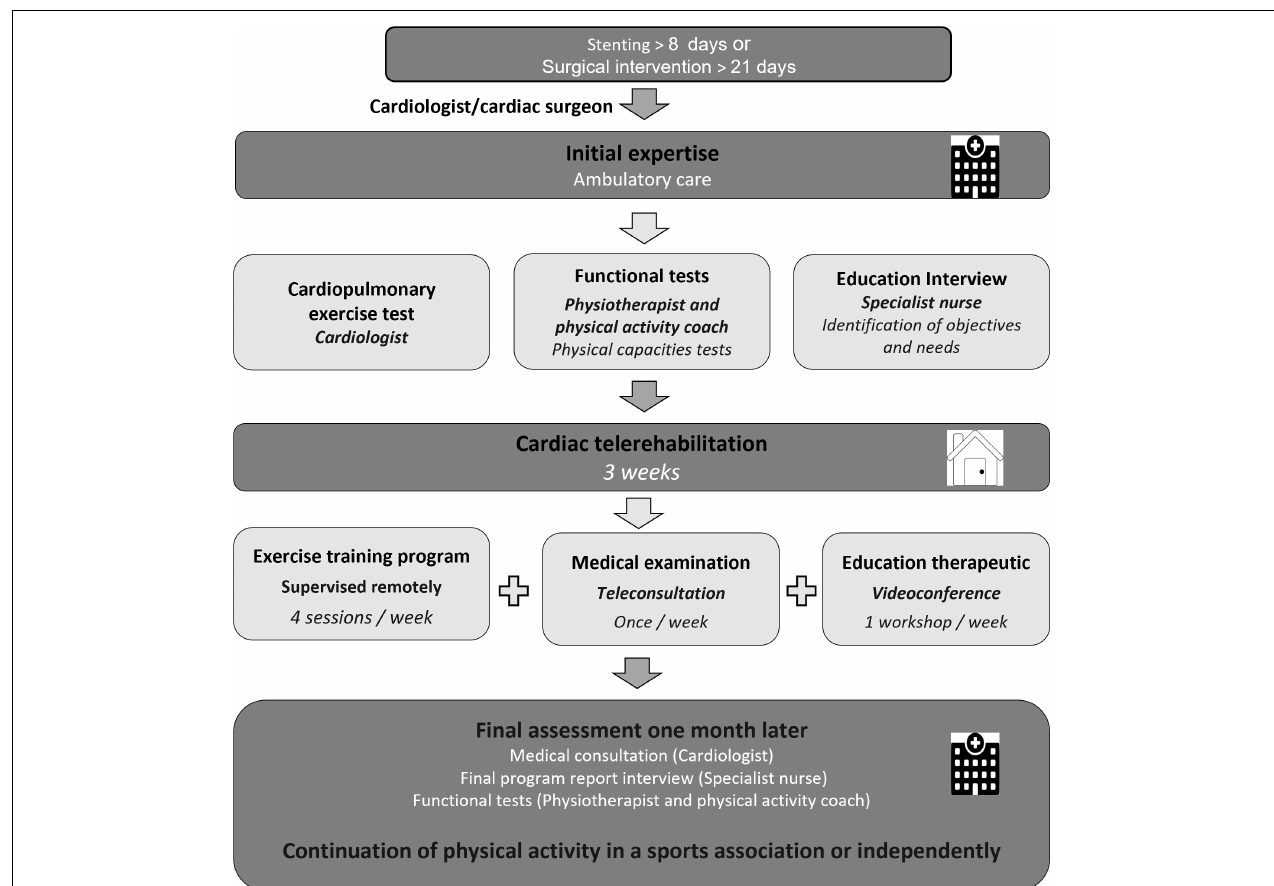
FIGURE 2 | Experimental design of telerehabilitation